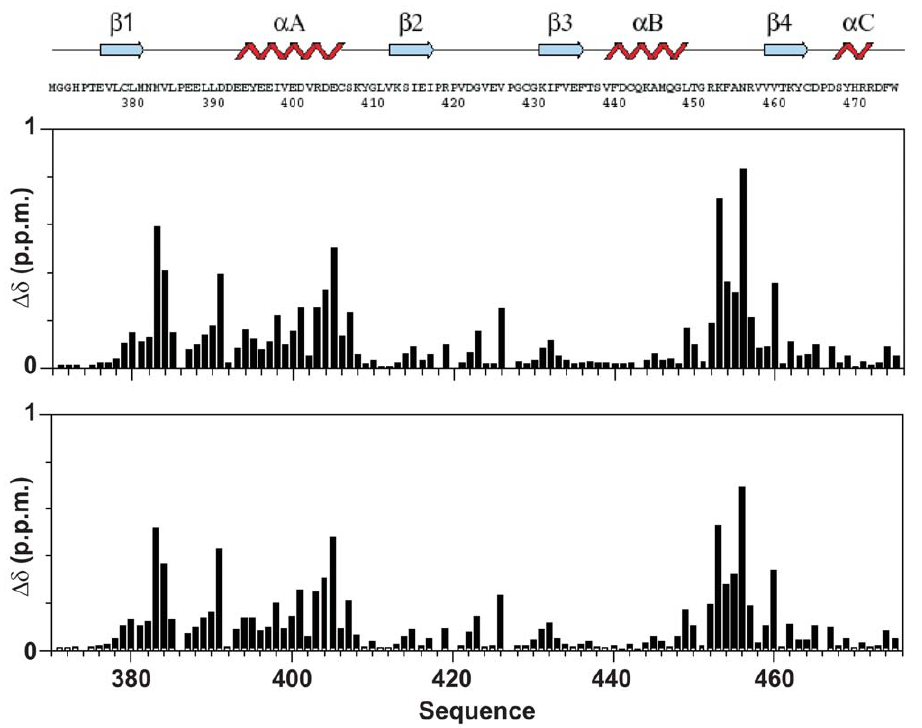
Figure 2. Mapping the effect of Atx1 peptides on U2AF65. Weighted chemical shift perturbation of U2AF65 upon titration with Atx1_S_ULM_PE (upper panel) and Atx1_pS_ULM_PE (lower panel). The U2AF65 sequence and secondary structure elements are indicated.